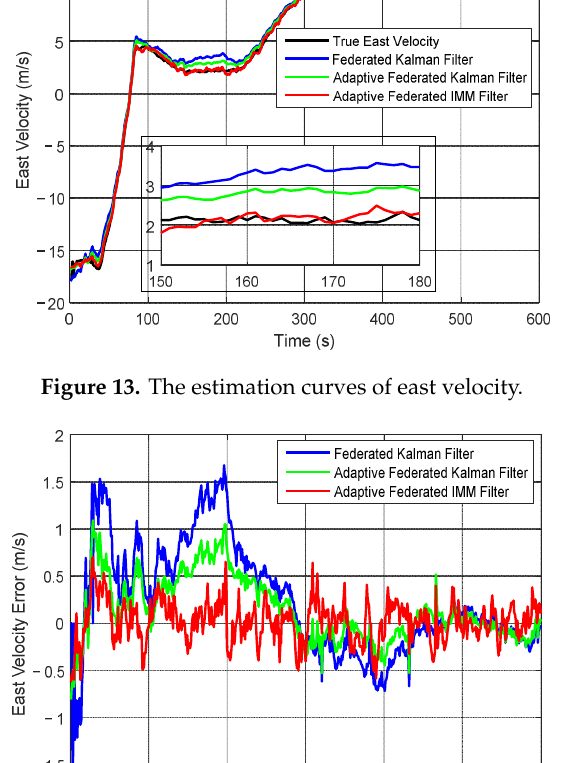
Figure 15. The estimation curves of north velocity.